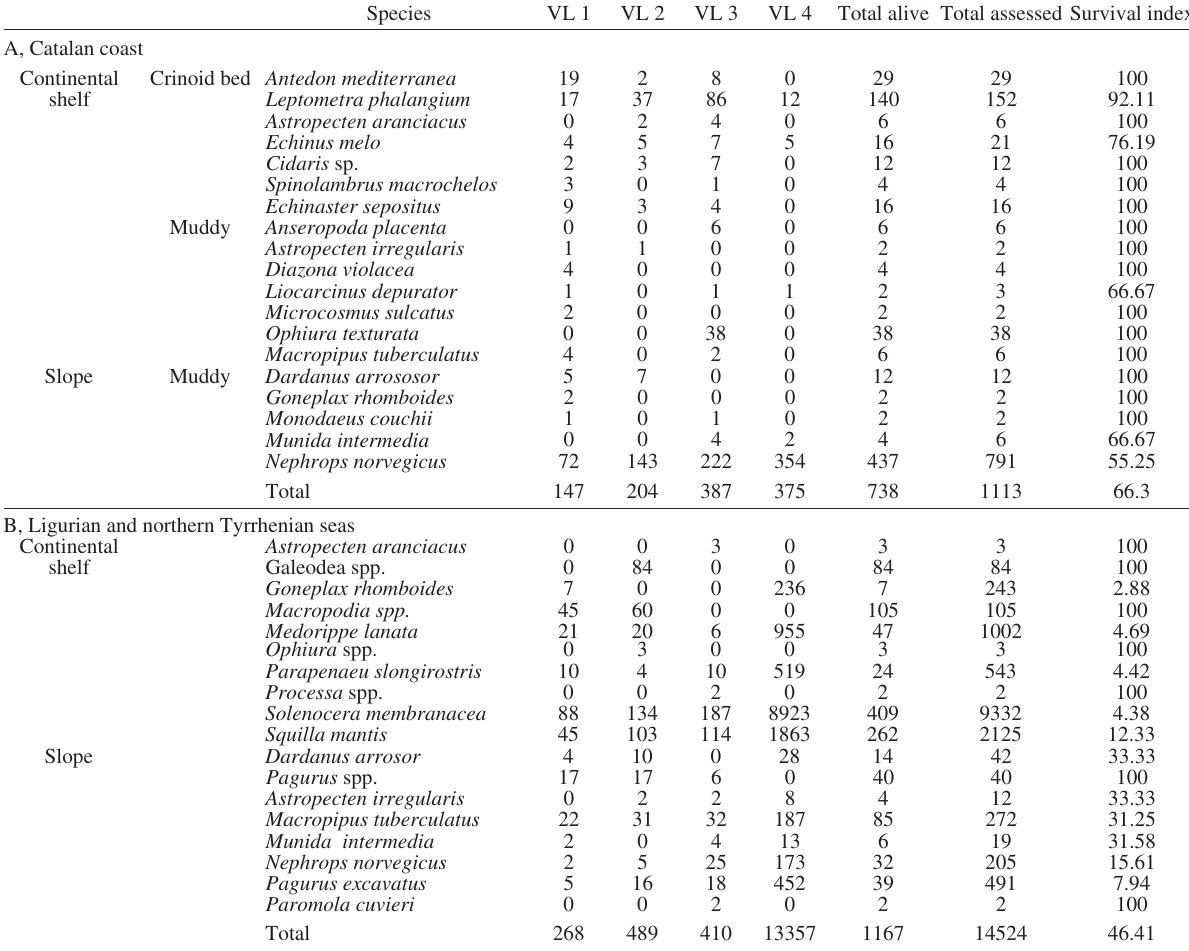
Table 3. – Vitality levels (VL) and survival index of discarded invertebrates estimated on deck: A, Catalan coast; B, Ligurian and northern Tyrrhenian